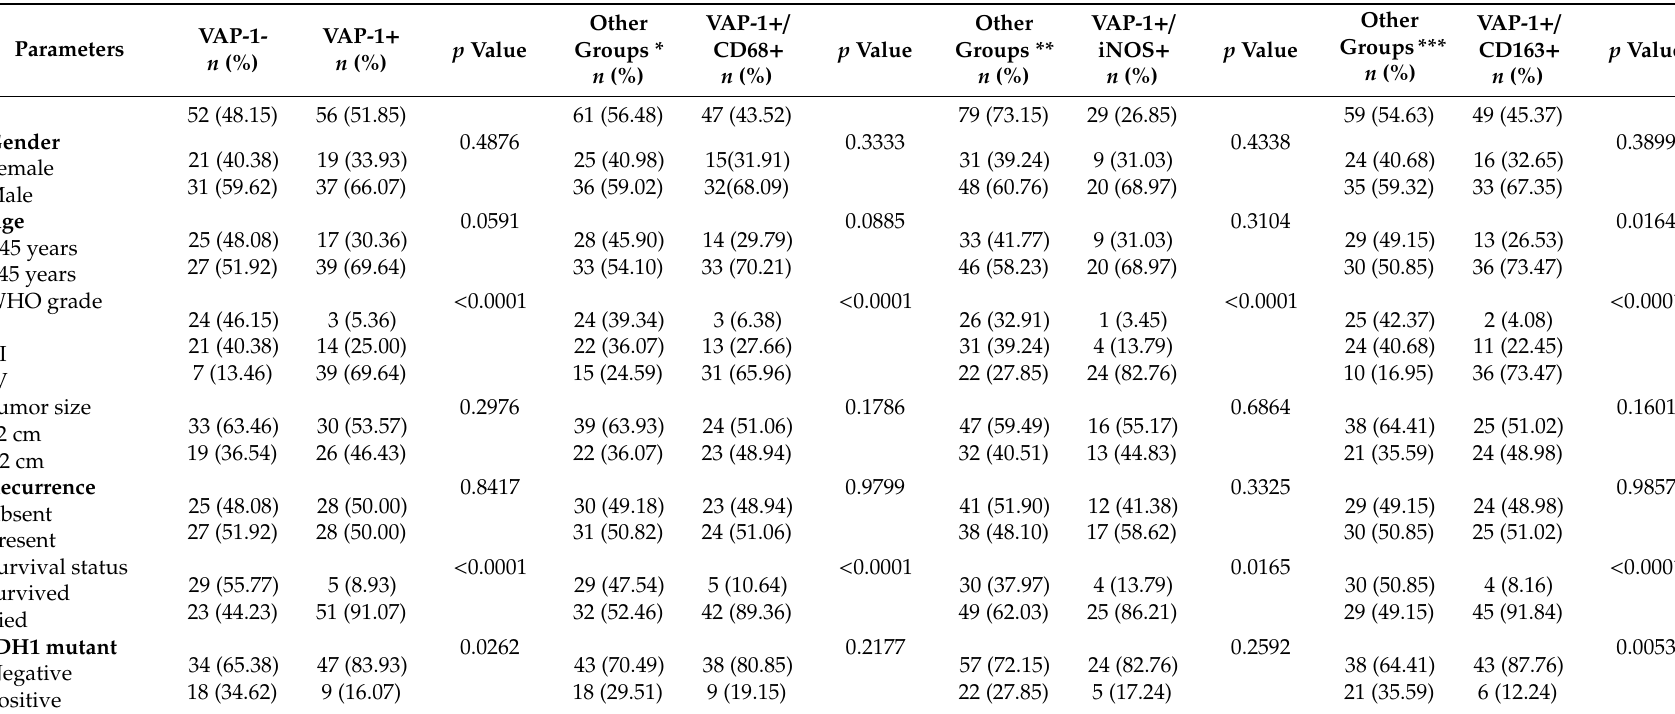
Table 2. Associations between VAP-1 or combined VAP-1 / TAM-related proteins and known clinicopathological parameters in 108 patients with glioma.